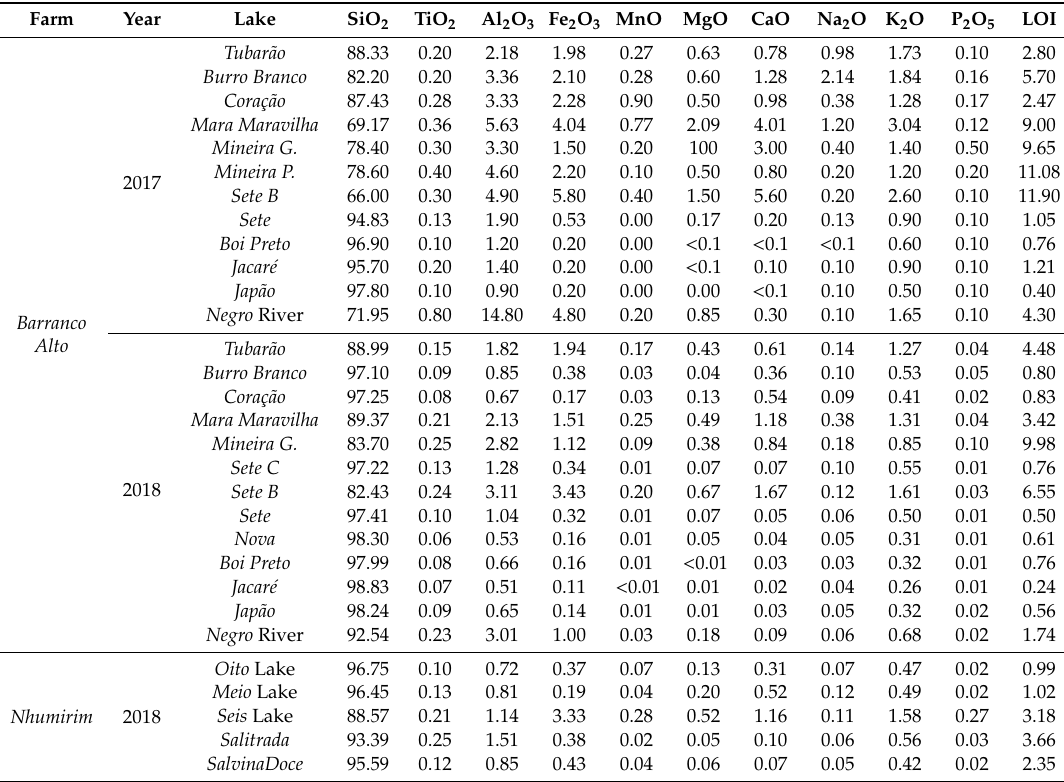
Table 5. Major elements (wt.% of the bulk sediments, measured by